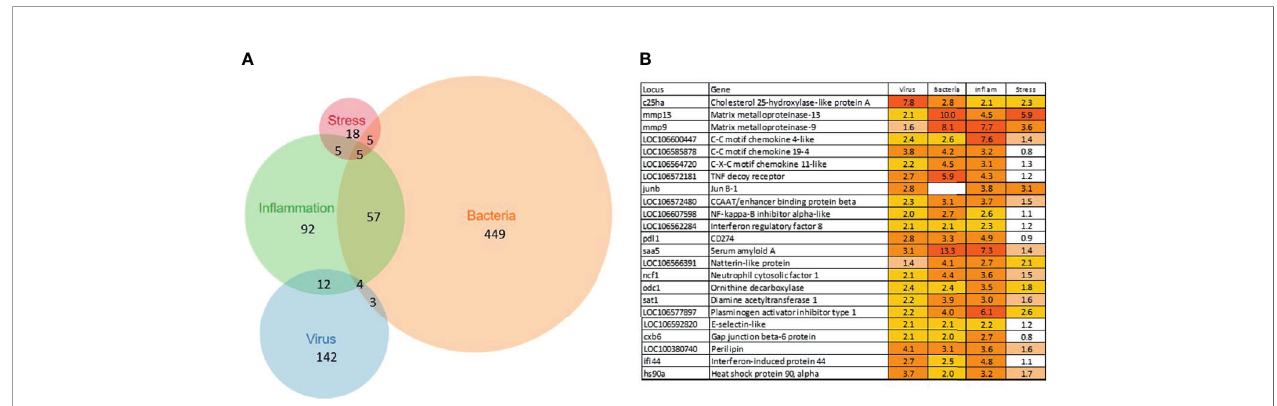
FIGURE 1 | Transcription modules. (A) numbers of up-regulated genes and overlap between TMs. The down-regulated genes are speci fi c for each TM, no sharing between TMs. (B) multifunctional genes assigned to at least three TMs.